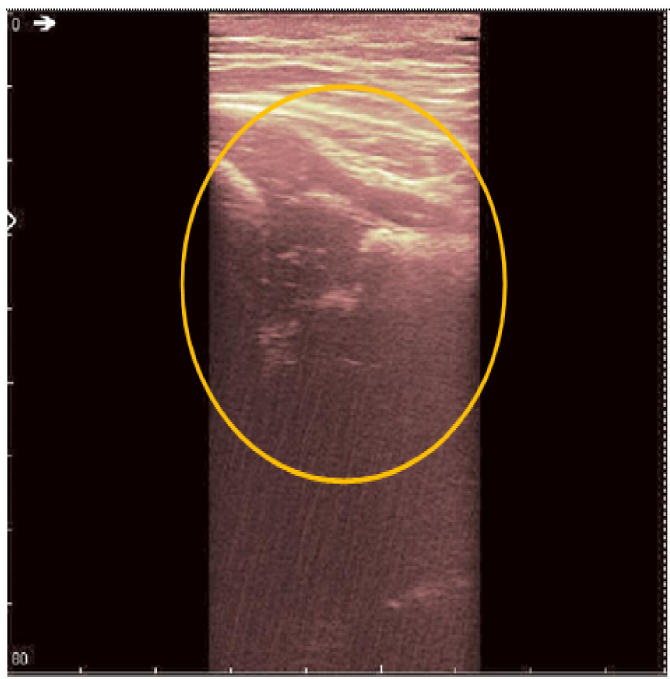
Figure 9. Denoising result for Image 2. An ultrasound (Image 3 (Figures 10 and 11)) was taken of a male patient with a sample frequency of 7.5 MHz and a frame rate of 29 fps. The parameters are same as in the previous two cases, yet the image of the acetabulum is hardly visible.